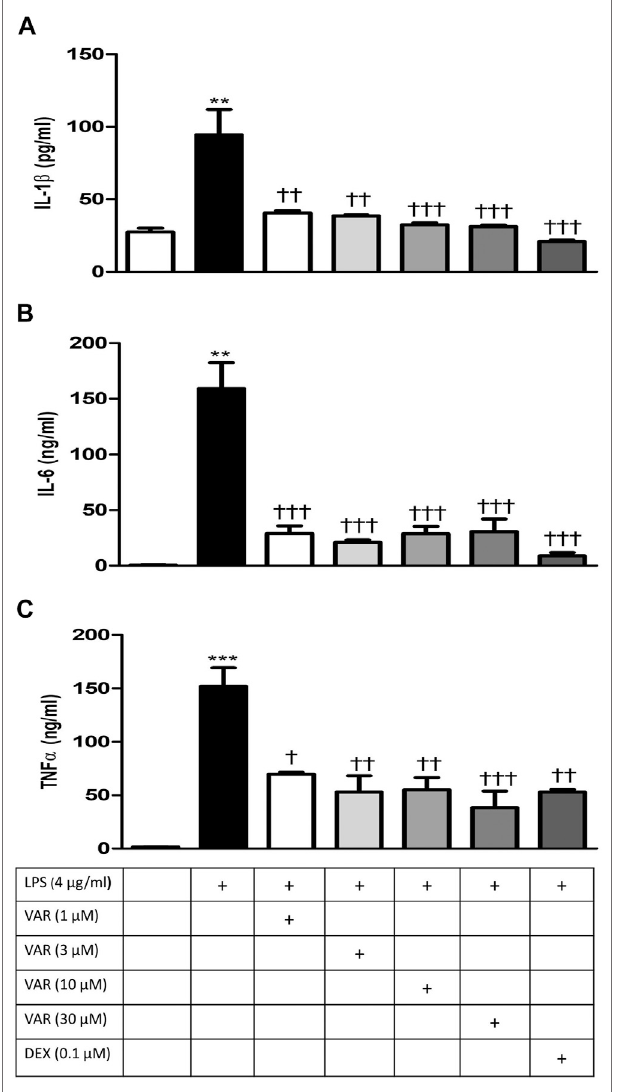
FIGURE 3 | Effects of varenicline on LPS-induced IL-1 β , IL-6, and TNF α elevationsvianAChR.Shownaretheeffectsofvareniclineon4 μ g/mlLPS-induced IL-1 β (A) ,IL-6 (B) ,and TNF α (C) levelsandthecomparison with dexamethasone. Data are expressed as mean ± S.E.M. (**, p < 0.01; ***, p < 0.001 vs. the controlgroup; † p < 0.05; †† p < 0.01, ††† p < 0.001vs.theLPSgroup, n (cid:1) 5 – 7,One- way ANOVAwith post hoc Tukey – Kramer multiple comparisons test or Student ’ s t -test). VAR: varenicline, DEX: dexamethasone.